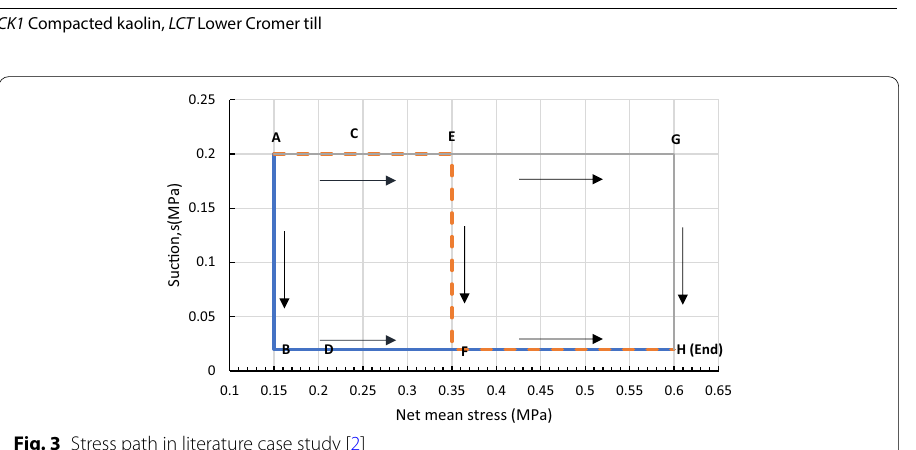
Fig. 3 Stress path in literature case study